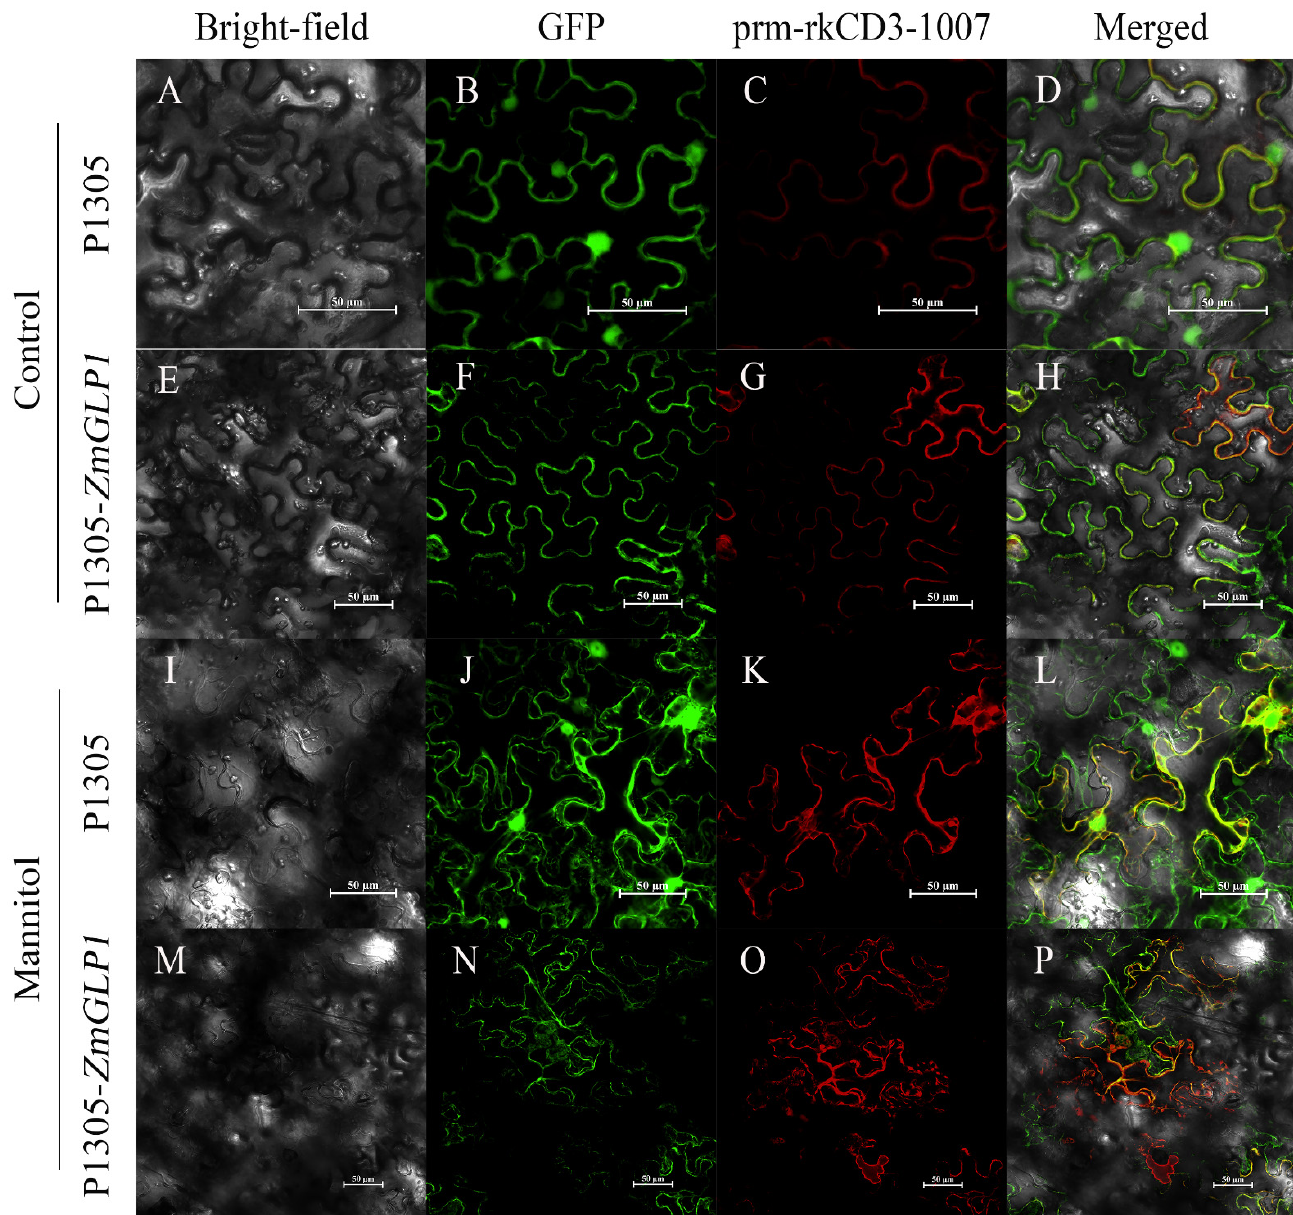
Figure 4. ZmGLP1 location in the cell wall and plasma membrane. ( A – D ) Subcellular